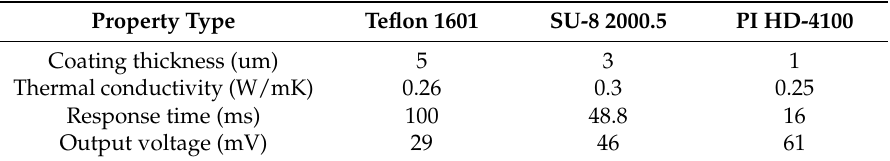
Table 5. Comparison between response times and output voltages [14–19].